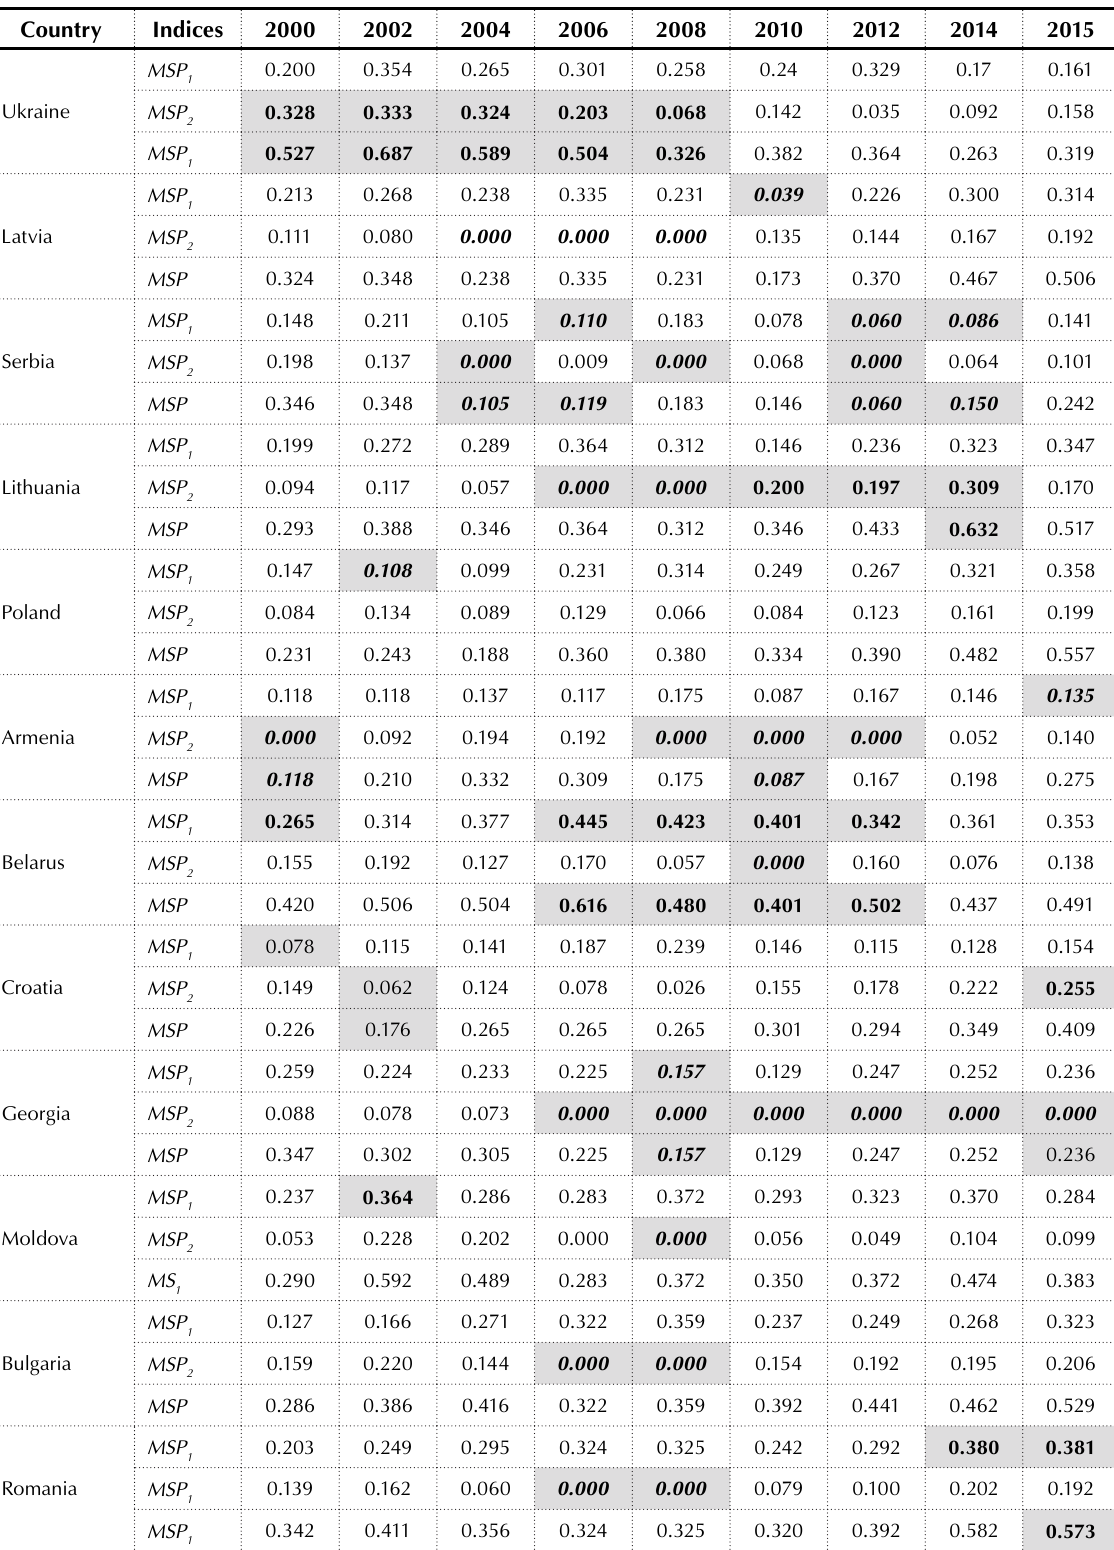
Table 2. Sub-indices and th e MSP index for the lower-middle-income economies of the EU countries for time period 2000–2015 (calculations based on Eurostat data)